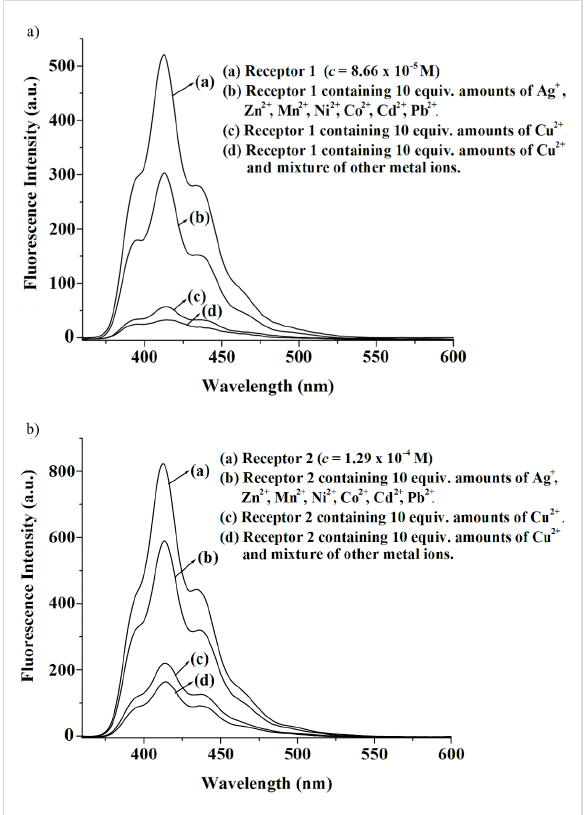
Figure 7: Change in emission of 1 ( c = 8.66 × 10 − 5 M) (a) and 2 ( c = 1.29 × 10 − 4 M) (b) upon addition of 10 equiv amounts of Cu 2+ in the presence and absence of other metal ions in CH 3 CN containing 0.2% DMSO.